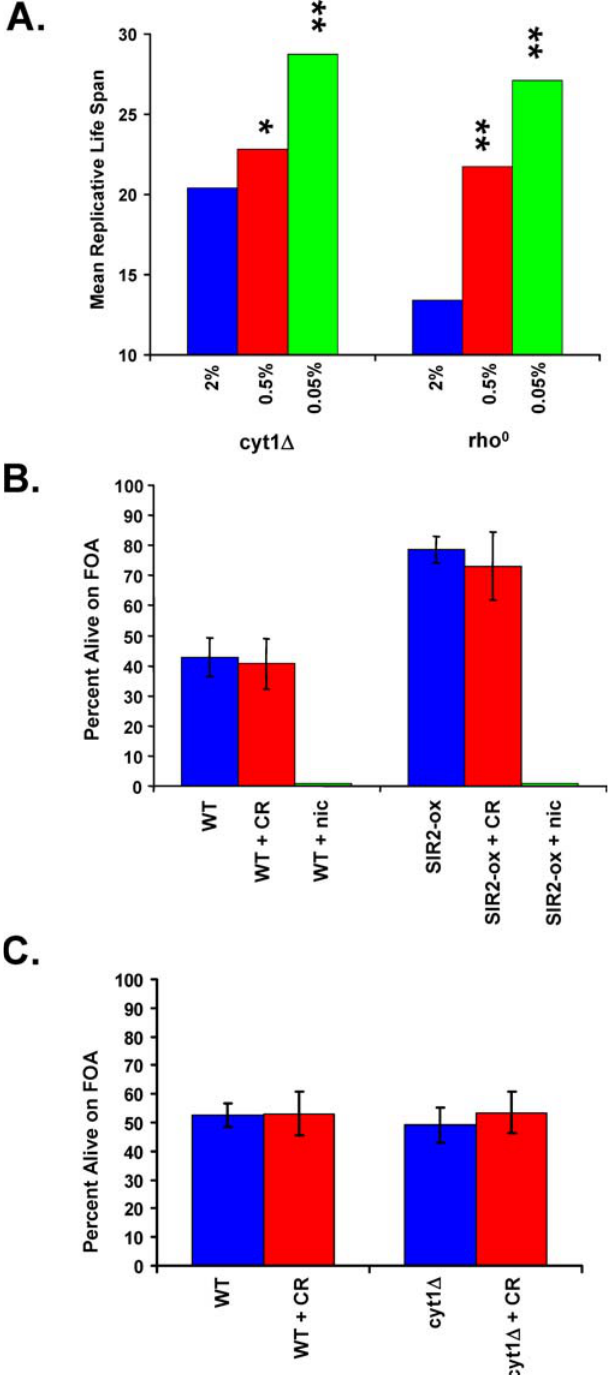
Figure 3. Effect of Glucose Concentration on Life Span and Sir2 Activity in Respiratory-Deficient Mutants (A) Mean replicative life span is significantly increased in PSY316 AUT cyt1 D and rho 0 cells as the glucose concentration is decreased to either 0.5% or 0.05%, relative to life span on 2% glucose. * p , 0.05, ** p , 0.01. (B) Sir2 activity is not increased by CR but is responsive to increased expression of Sir2 or to addition of exogenous nicotinamide. Transcrip- tional silencing of the telomeric URA3 marker in PSY316AUT (WT) was monitored by the survival of cells plated onto medium containing 5-FOA. (C) Sir2 activity is not altered in respiratory deficient cyt1 D cells and is unaffected by CR. Transcriptional silencing of the telomeric URA3 marker in PSY316AUT (WT) was monitored by the survival of cells plated onto medium containing 5-FOA. DOI: 10.1371/journal.pgen.0010069.g003 PLoS Genetics |